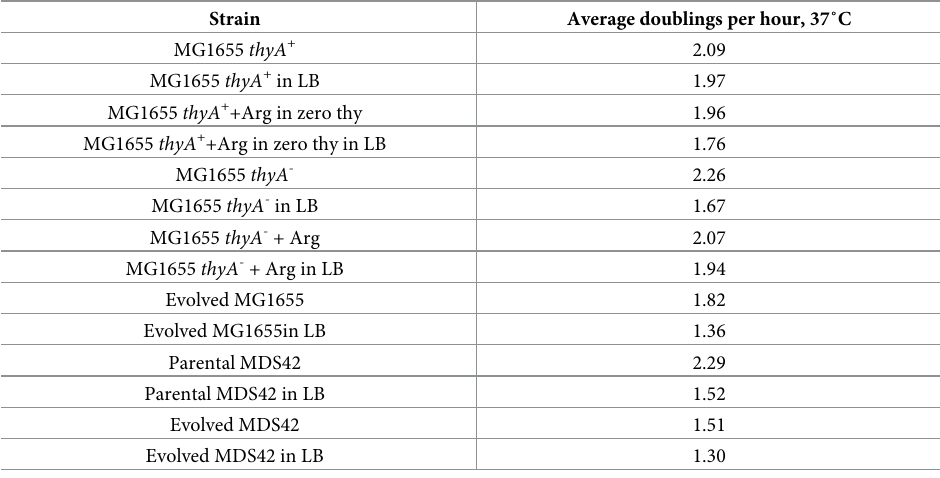
Table 6. Growth rates of strains in rich defined media vs.